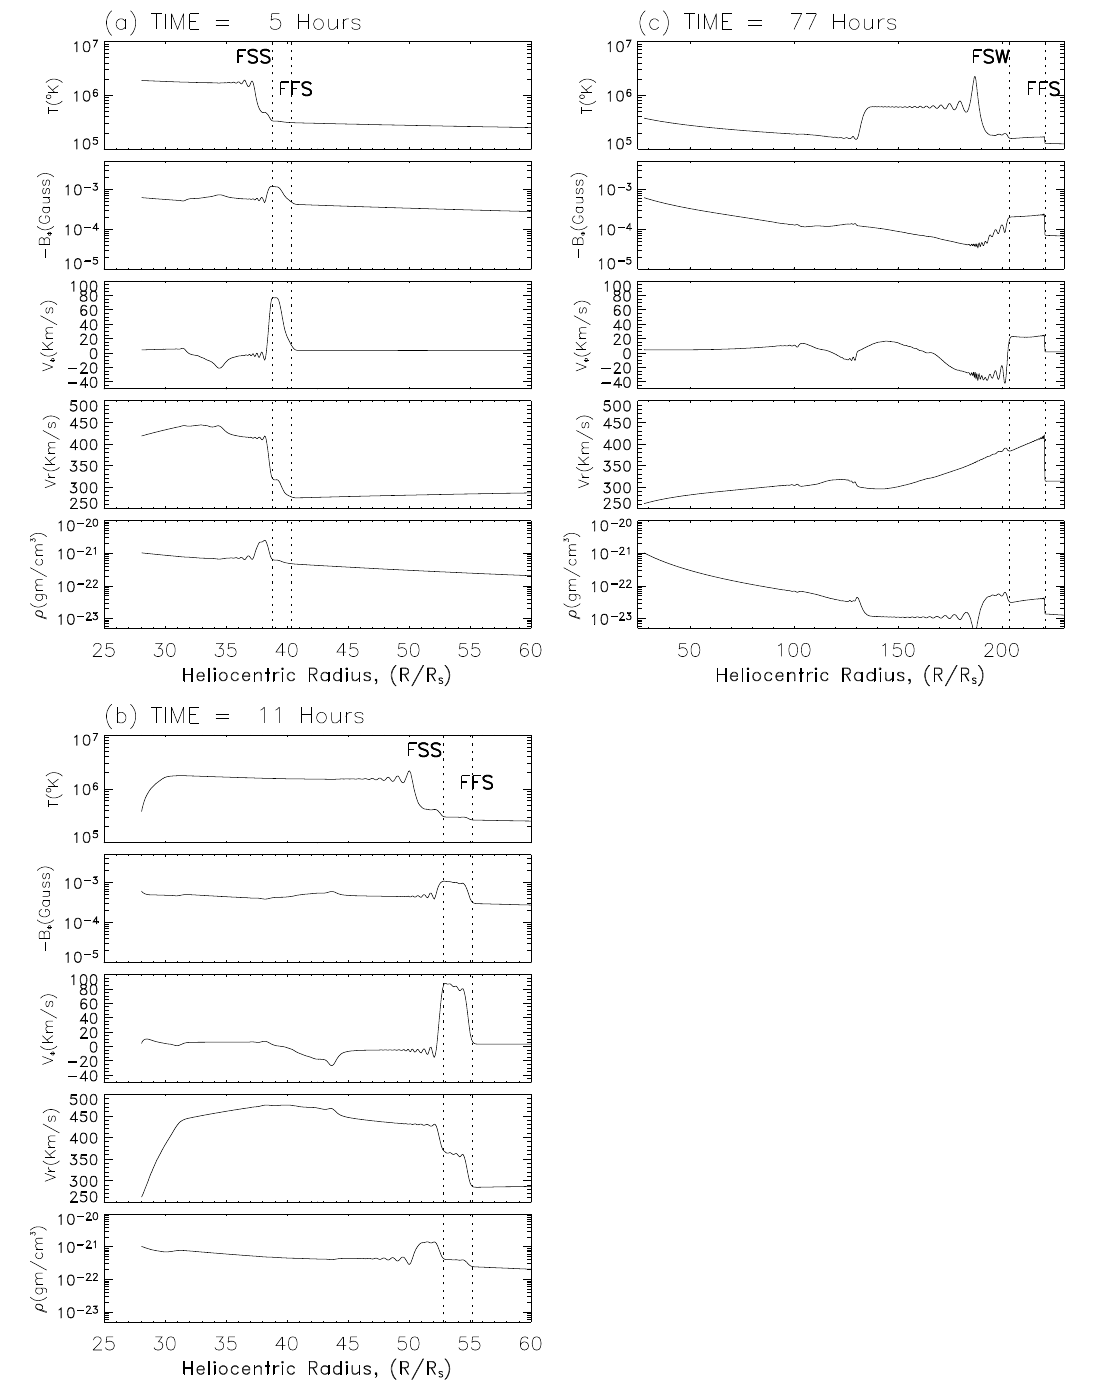
(cid:12)(cid:0)(cid:6)(cid:9)(cid:5)(cid:0)(cid:5)(cid:1) (cid:12)(cid:10)(cid:6)(cid:9)(cid:15) (cid:1)(cid:2) 0 . = 1 . 6 , T 0 = 5 . 0. (a) , (b) and (c) show the solar wind solution versus r (cid:5)(cid:3) (cid:0) v r ◦ T ◦ (cid:2)(cid:4)(cid:3) (cid:0)